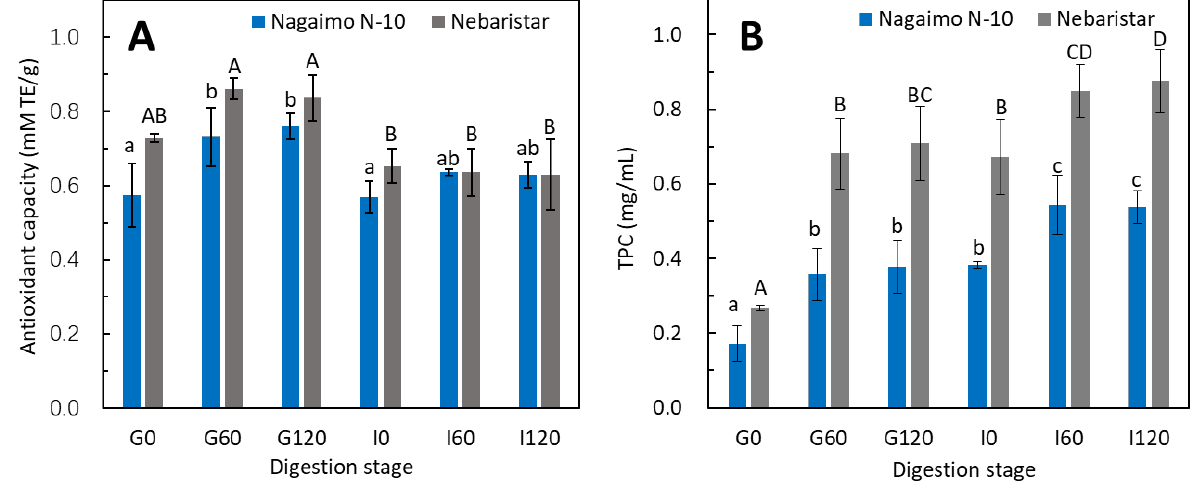
Figure 4. Changes in total antioxidant capacity (TAC) and total phenolic content (TPC) of the raw yam tubers during simulated in vitro digestion. Different lowercase letters (a–c) indicate significant differences ( p < 0.05) for the Nagaimo N-10 sample collected at different digestion stages. Different uppercase letters (A–D) indicate significant differences ( p < 0.05) for the Nebaristar sample collected at different digestion stages. ( A ): Changes in total antioxidant capacity (TAC) of both samples; ( B ): Changes in total phenolic content (TPC) of both samples.